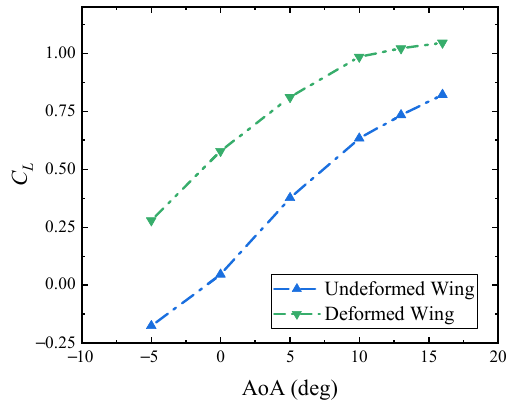
Figure 16. Comparison of lift coefficients between deformed and undeformed wing.